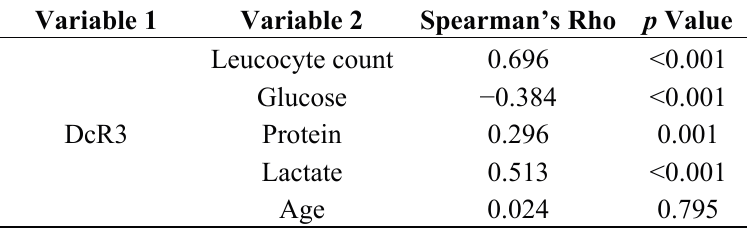
Table 4. Correlation between age/CSF parameters and CSF DcR3